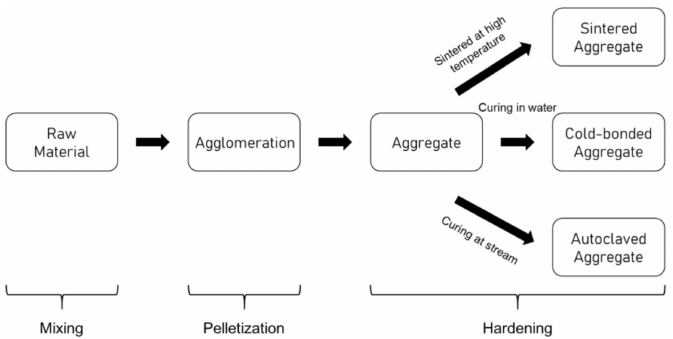
Figure 1. Flow chart of producing lightweight aggregate. Table 1. Previous studies on the type of method to manufacture lightweight